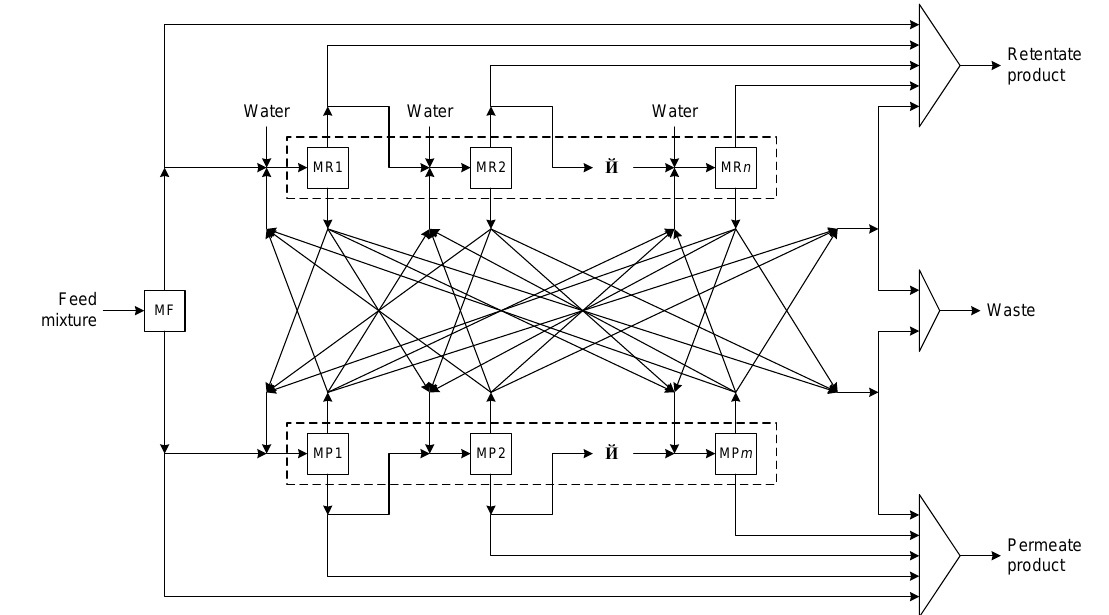
Figure 2. Superstructure for an NF membrane network.